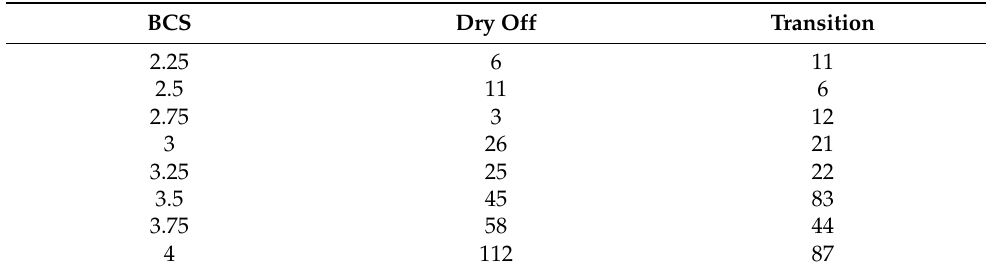
Table 1. Distribution of the number of different BCS for the construction of warning function. BCS Dry